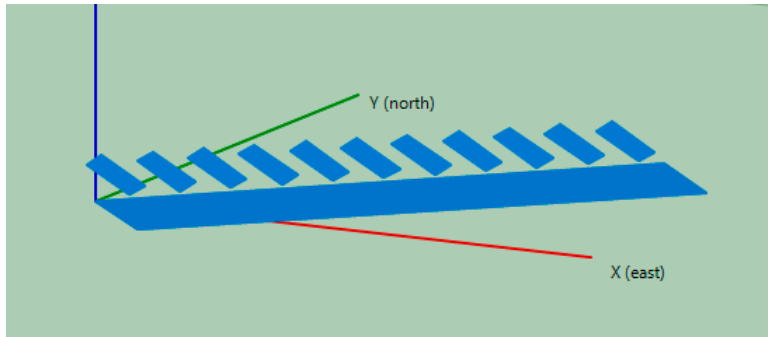
Figure A2. Due southwest APV shed.